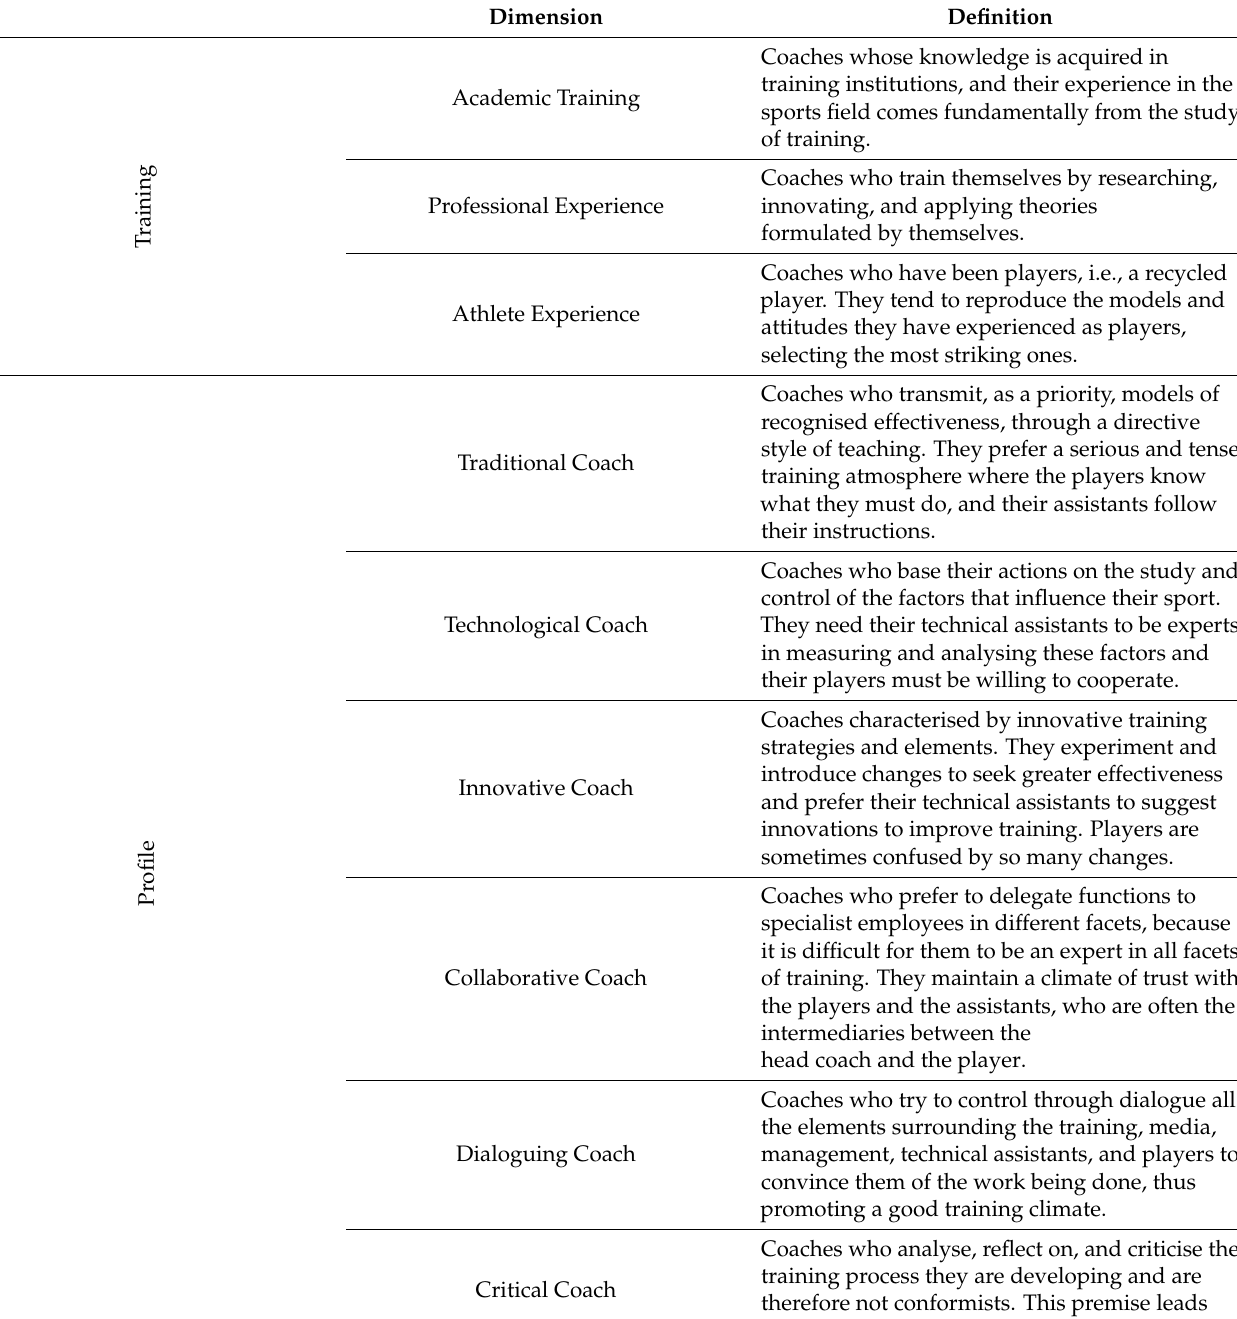
Table 2. Definitions of the trainer models: Training and Profile (Adapted from Ib á ñez [15,16]).